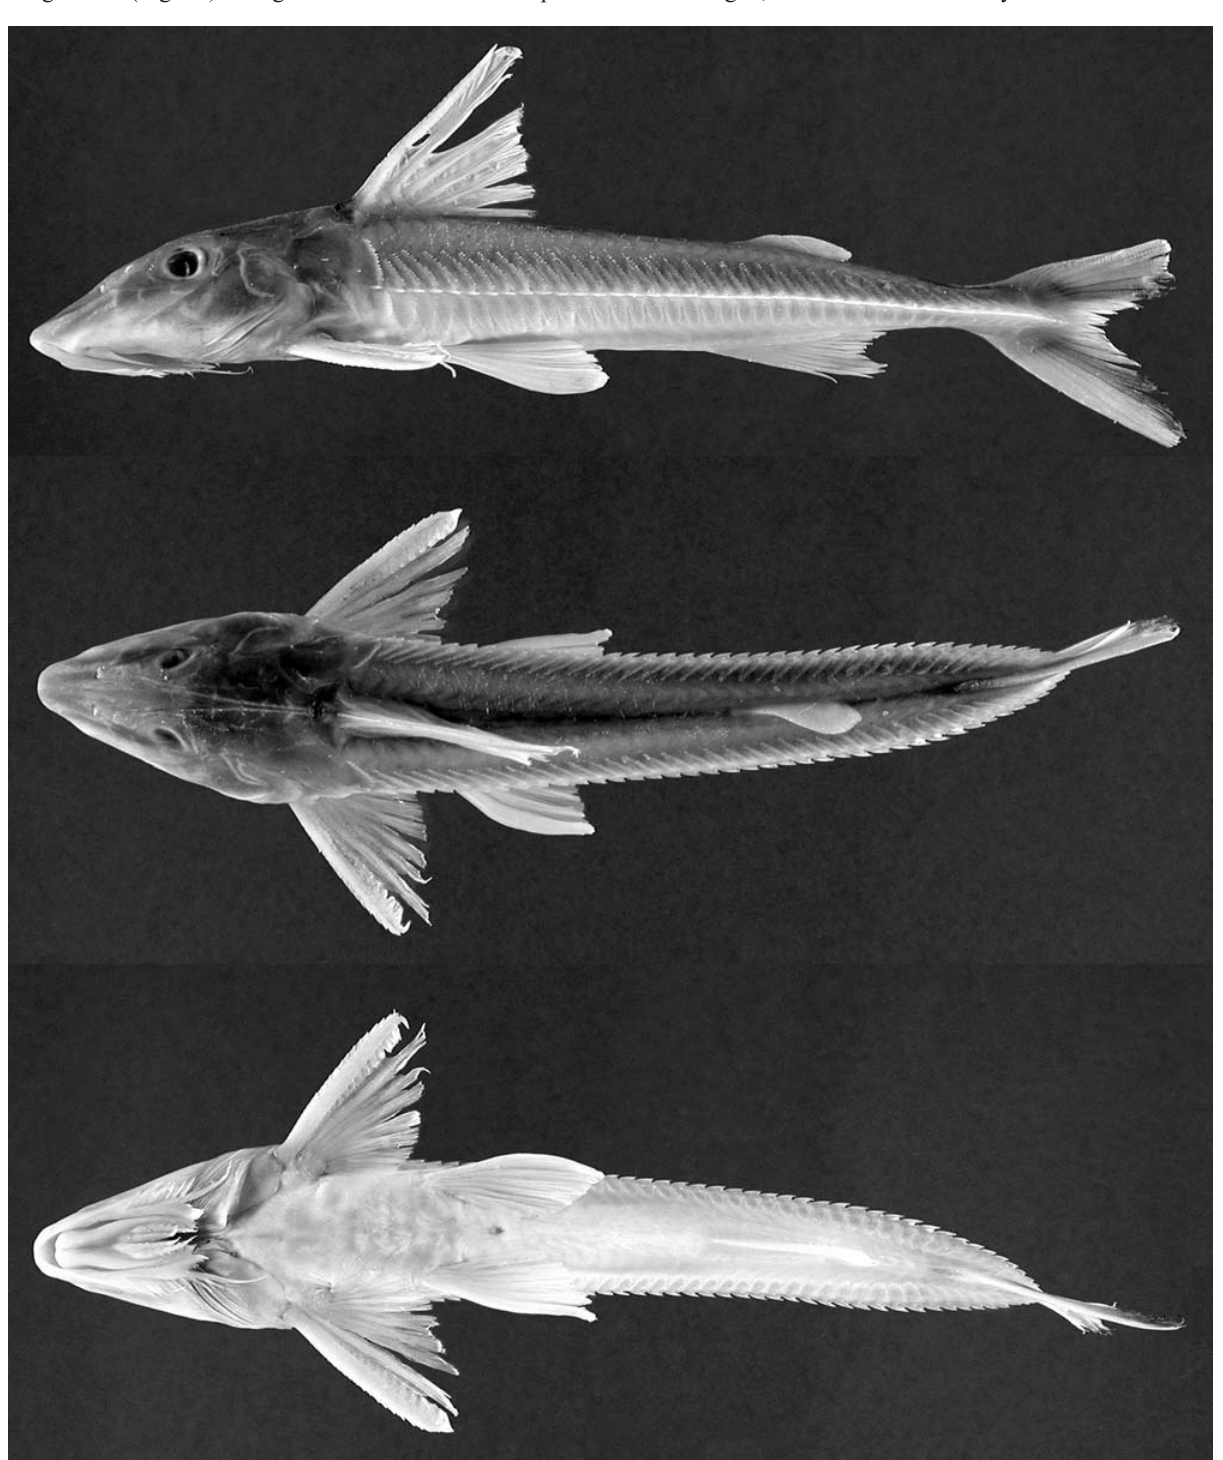
Fig. 24. Leptodoras cf. cataniai Nanay form, ANSP 178438 (SL 164.2 mm), río Nanay (Amazonas dr.), near Iquitos, Loreto,